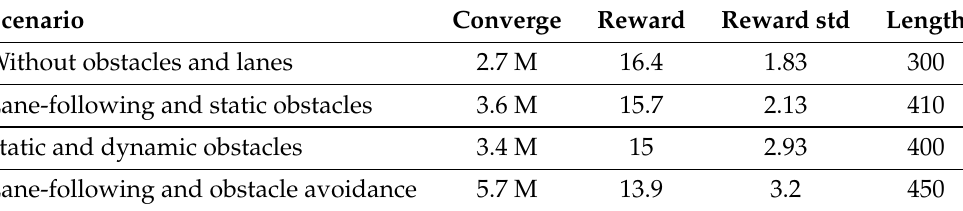
Table 2. Agent training performance for different